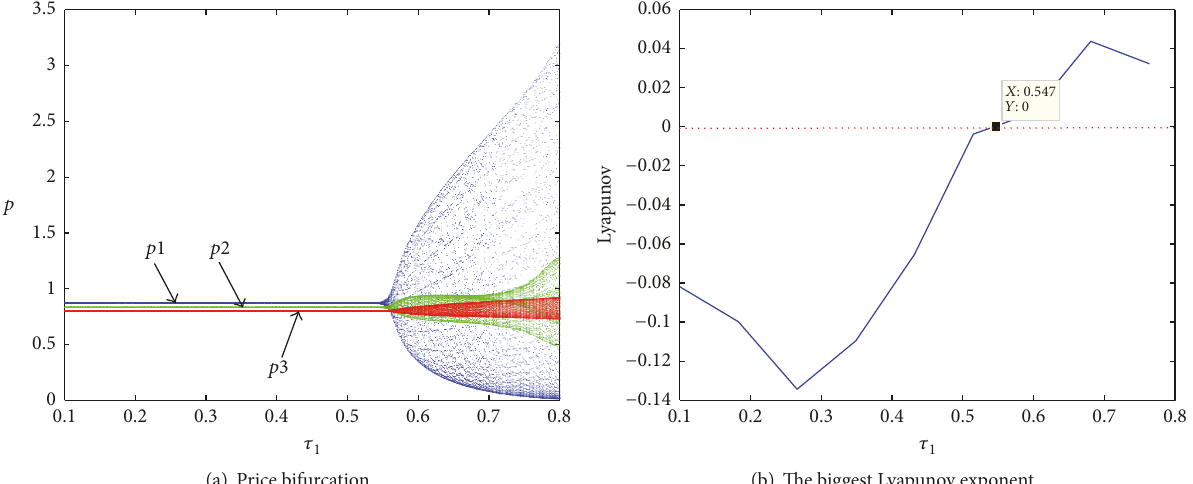
Figure 2: The attractor of system (22) when 𝜏 2 = 0.45 .